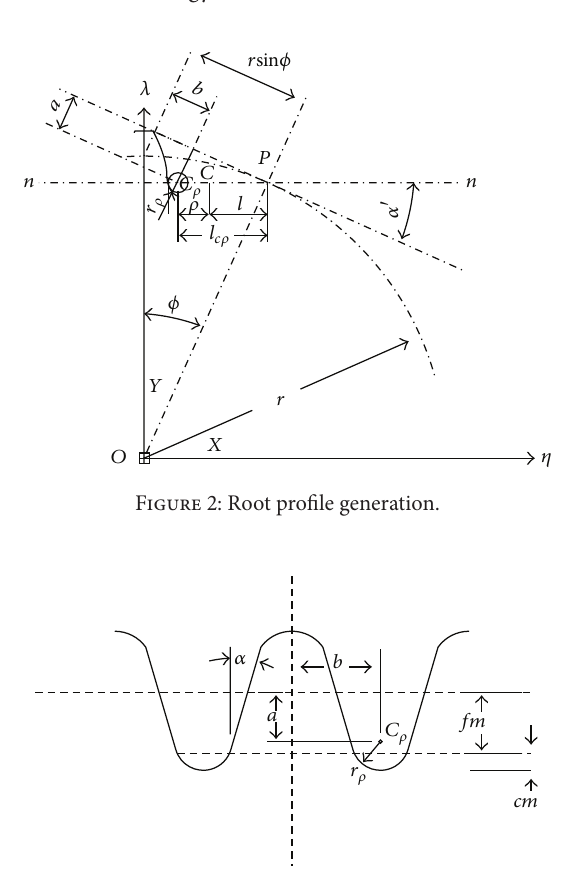
Figure 3: The hob tooth profile.